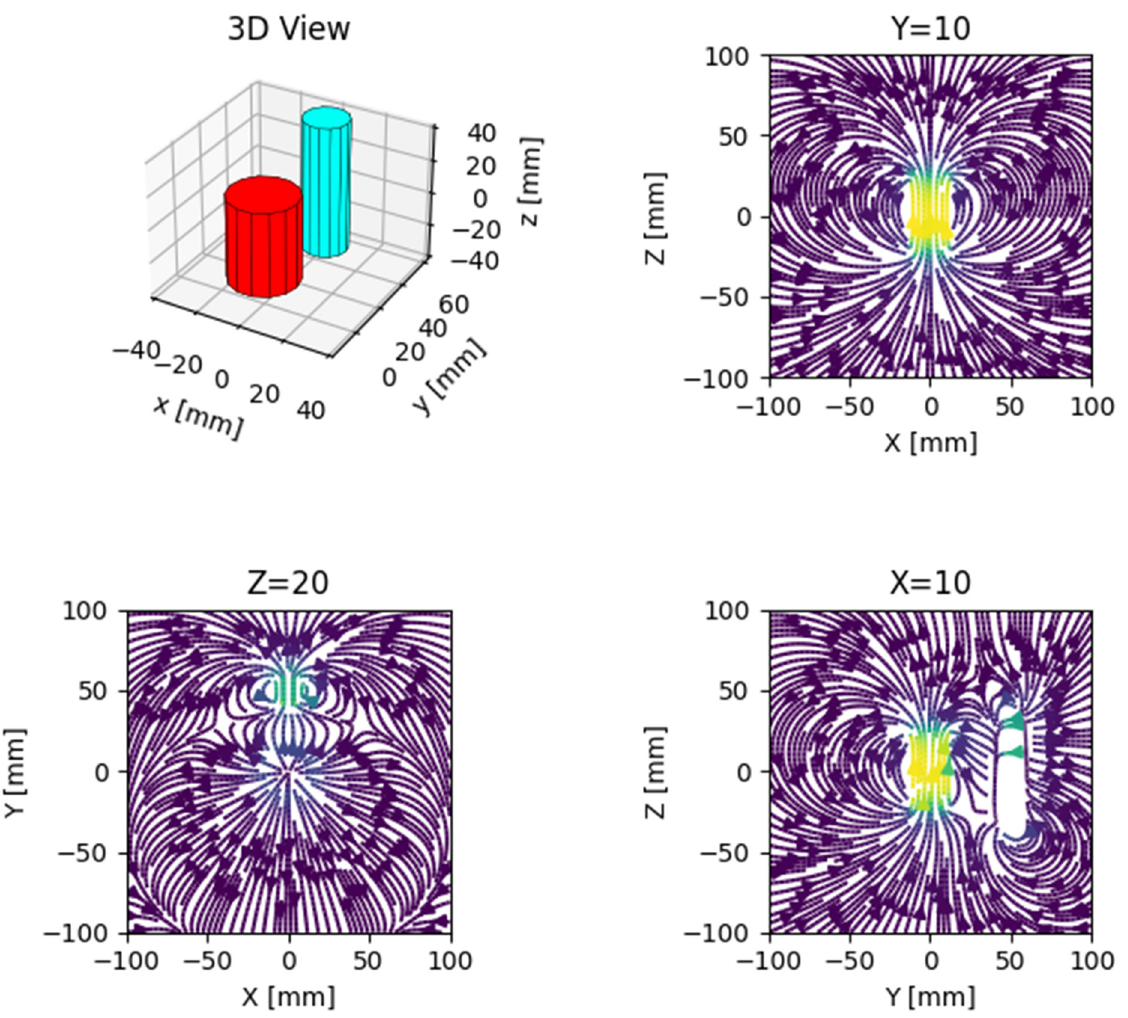
Figure 2. The shape of the magnetic field generated by two magnets observed from different planes.